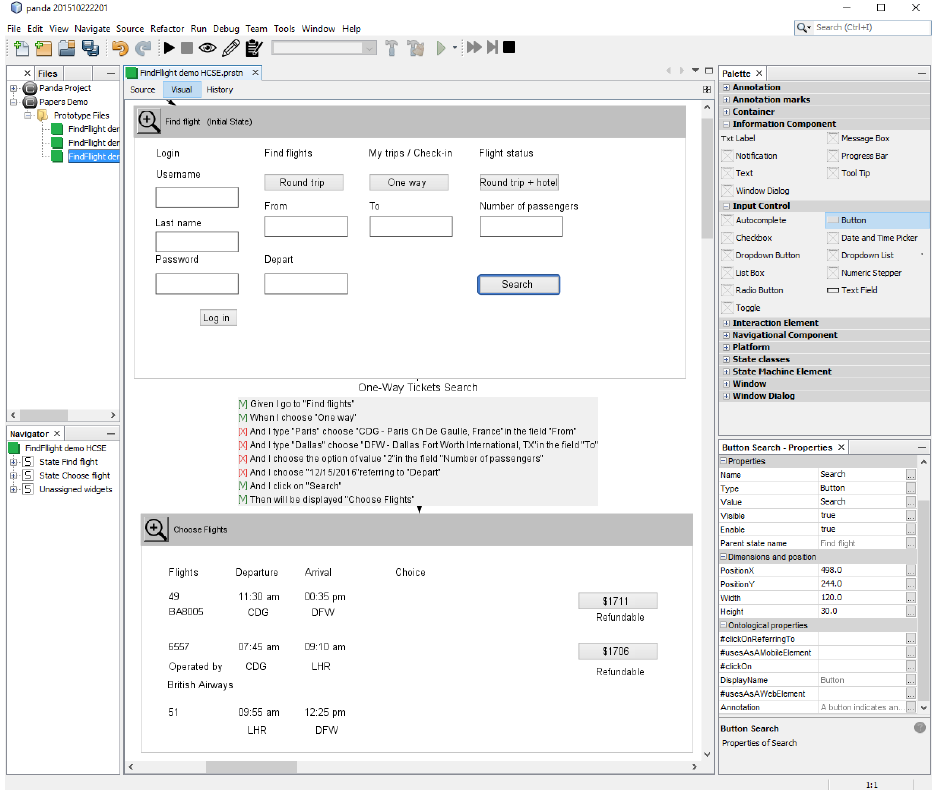
Figure 23. PANDA